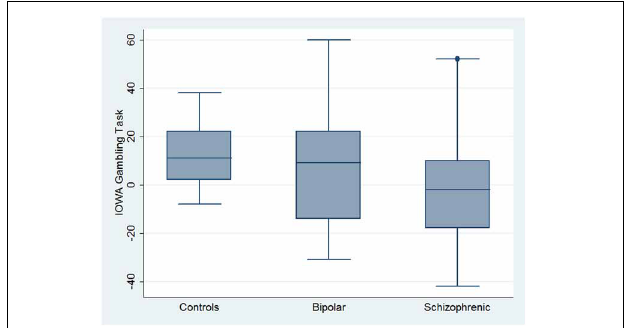
FIGURE 12 | Differences between groups in ESCB tasks: IGT. • Outliers.